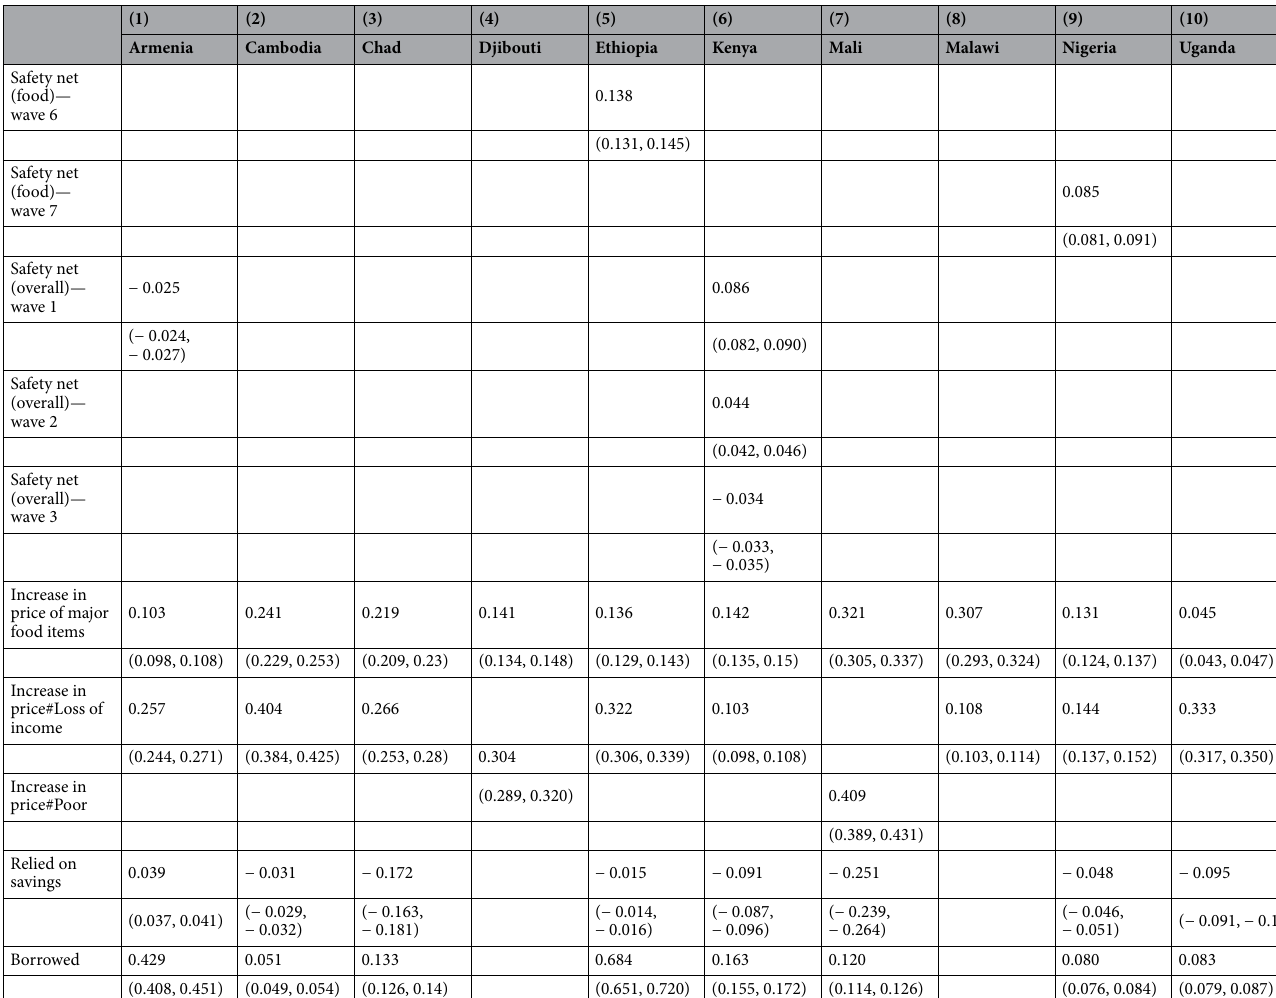
Table 3. Determinants of food insecurity—went without eating for a whole day. 95% CI in